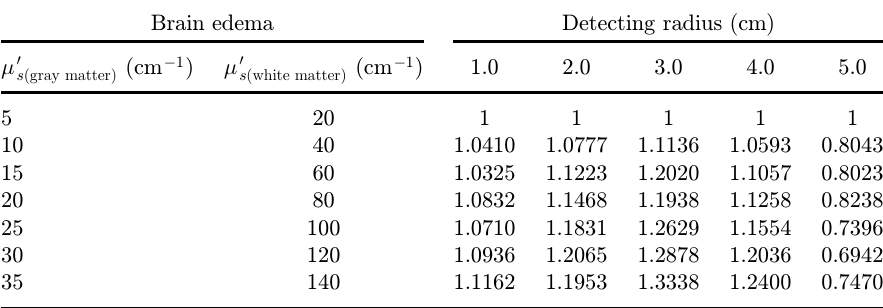
Table 4. The normalized light intensity in Model 3 0 .